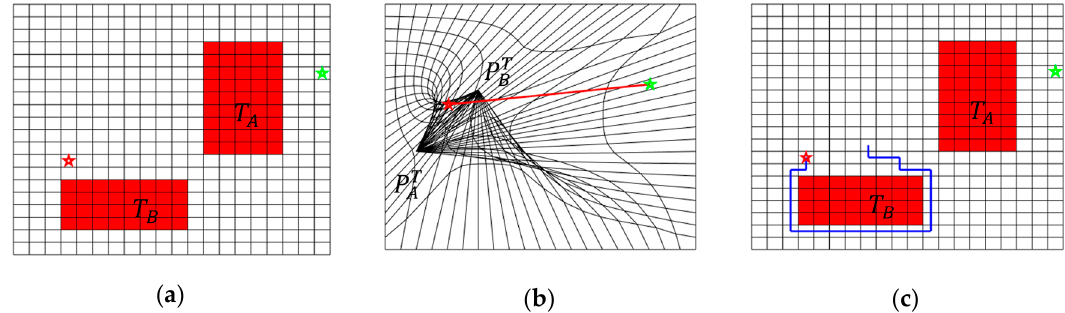
Figure 4. One 2D example of path planning failure in DC-space when improper distortion points are chosen for obstacles. ( a ) Initial C-space with obstacles ( 𝑇 (cid:3002) and 𝑇 (cid:3003) ) , the start point (red star), and the target point (green star). ( b ) The DC-space after the obstacles collapse, the upper-right obstacle 𝑇 (cid:3002) is distorted to the lower-left position 𝑃 (cid:3002)(cid:3021) , and the lower-left obstacle 𝑇 (cid:3003) is distorted to the upper-right position 𝑃 (cid:3003)(cid:3021) . Penetration between grids is observed. ( c ) The generated path (blue) in C-space falls into infinite loops and cannot achieve the